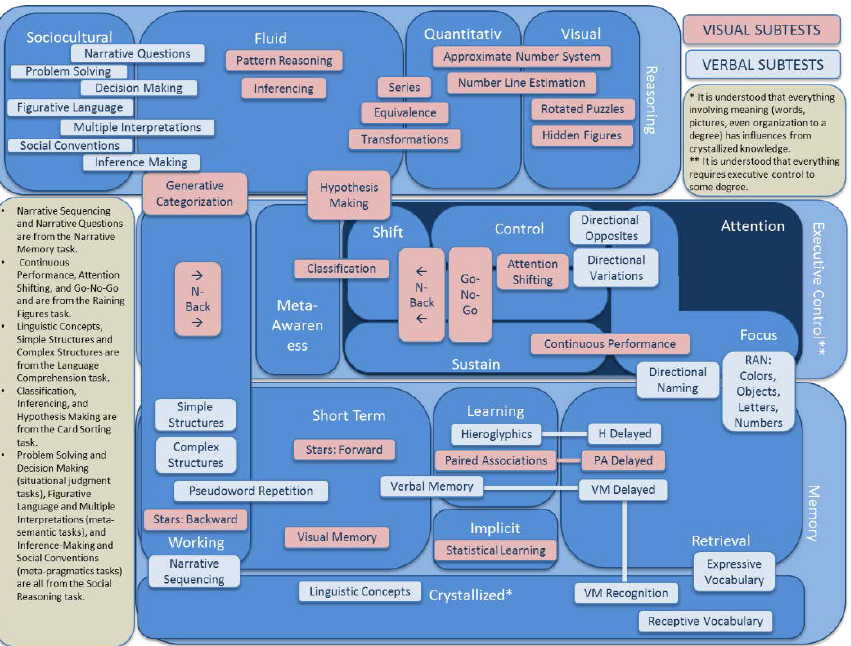
Figure 1. Alif–Ya’s subtests and their contributions to the assessment of memory, executive control, and reasoning.